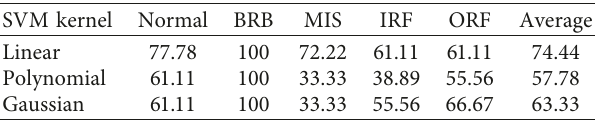
Table 7: Classification accuracy of the current signal by different SVM kernels (%).